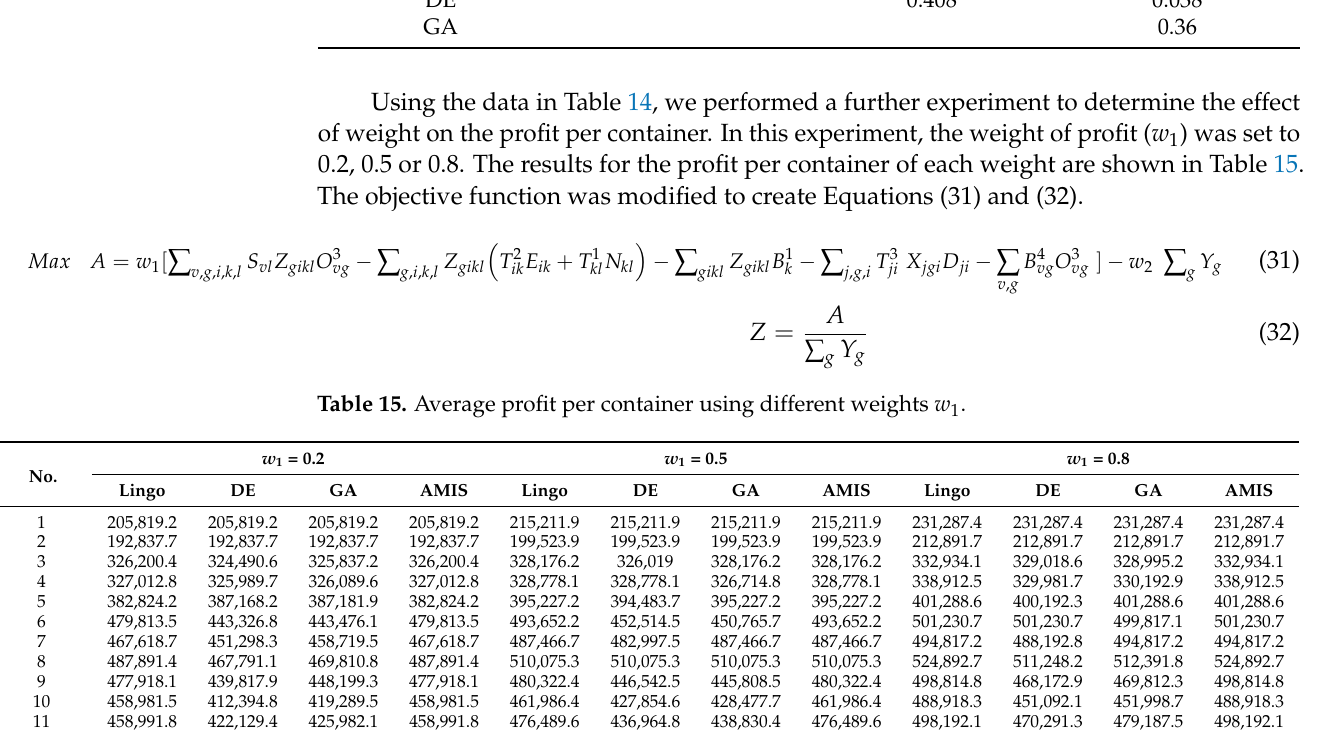
Table 14. Statistical testing using the Wilcoxon signed-rank test on the results in Table 13. DE GA AMIS Lingo 0.028 0.036 1.00 DE 0.408 0.038 GA 0.36